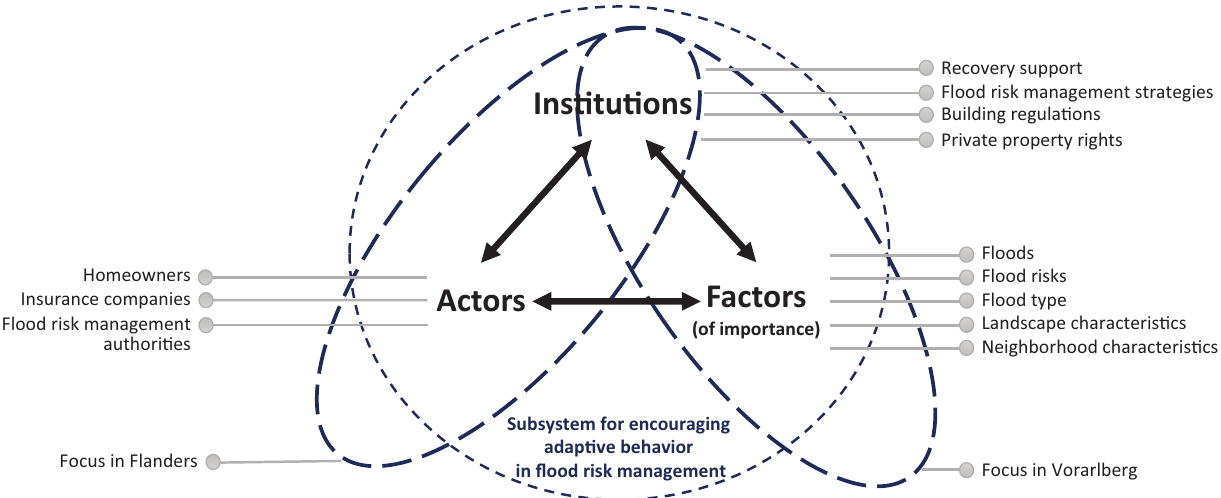
Figure 2. Scheme illustrating the dominant focus of both Flanders and Vorarlberg in encouraging adaptive behavior in flood risk management as an application of the actor‐relational subsystem by Boelens